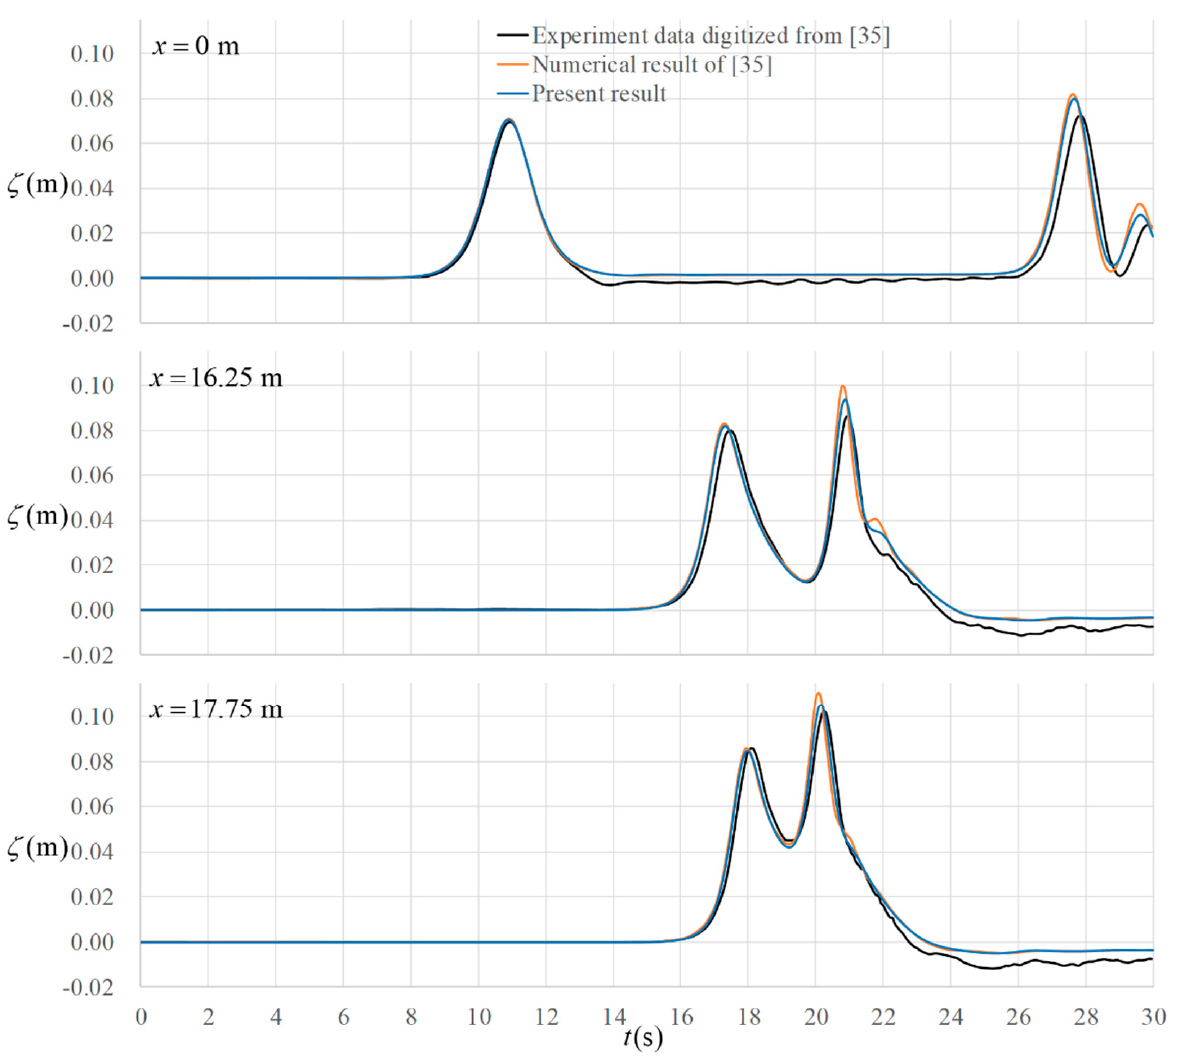
Figure 4. Comparison of the present numerical results with the other data for the case of solitary wave reflection after running up a slope.